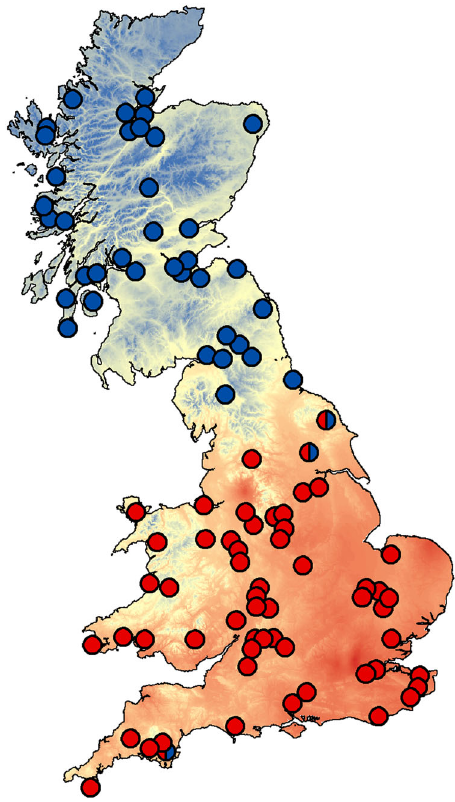
Fig. 1 Geographic pattern of bank vole haemoglobin in Britain. Records of HbS are indicated by blue fi lling of the circles, those of HbF by red. The three sites where both HbS and HbF were detected are fi lled in half blue and half red. The background heat map shows the variation in mean summer temperature represented by the WorldClim variable BIO10 52 (see text for details). The fi gure was created using ArcMap (v.10.8) and the Esri world countries dataset